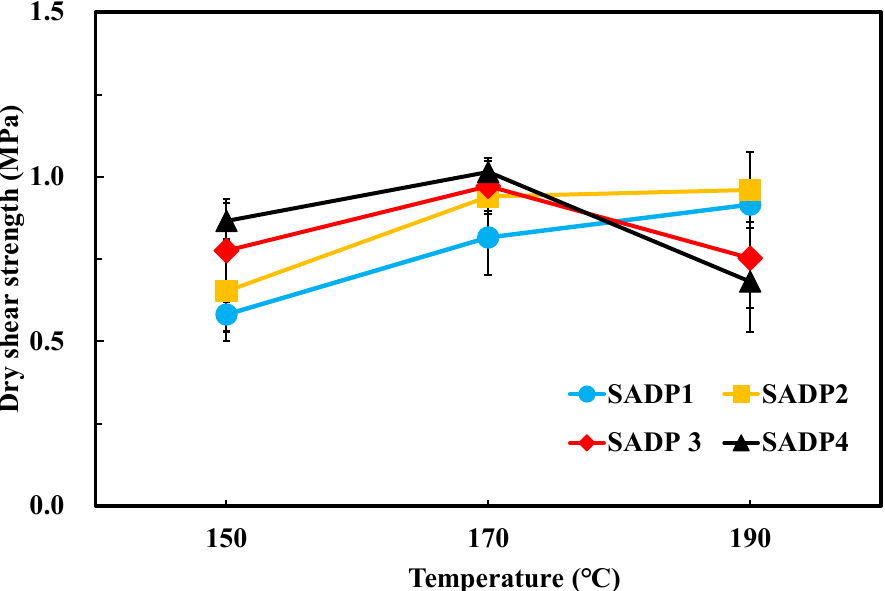
Polymers 2019 , 11 , 1909 Figure 3. Dry shear strength of the plywood bonded with SADP adhesives. Figure 3. Dry shear strength of the plywood bonded with SADP adhesives.